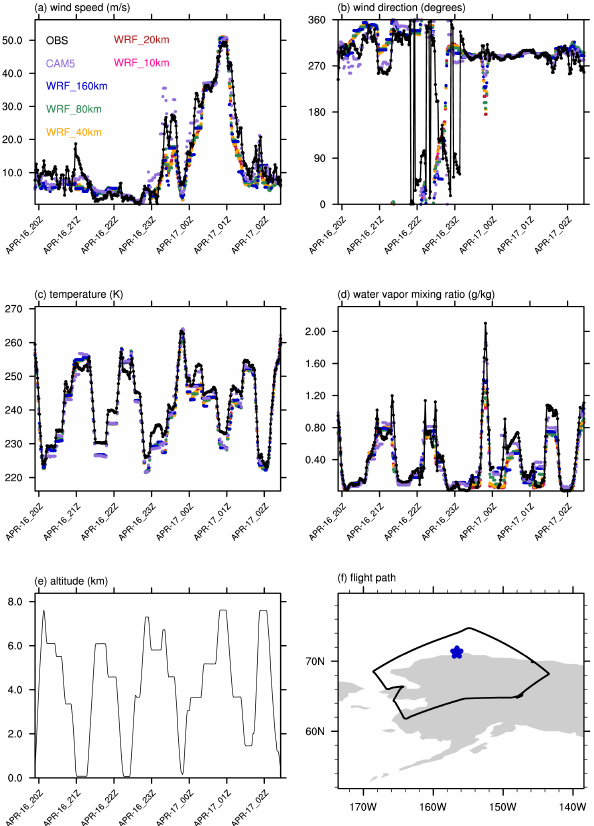
Fig. 4. Time series of observed and simulated (a) liquid water con- tent (gm − 3 ) and (b) ice water content (gm − 3 ) and 5th, 25th, 50th, 75th, and 95th percentile of observed and simulated (c) liquid wa- ter content (gm − 3 ) and (d) ice water content (gm − 3 ) over all of the aircraft flights. (e) and (f) depict the altitude and flight path, re- spectively, of 15 Convair-580 flight paths during the ISDAC field campaign. Vertical bars in (a) and (b) show the range of the 5th and 95th percentile of the observations within each